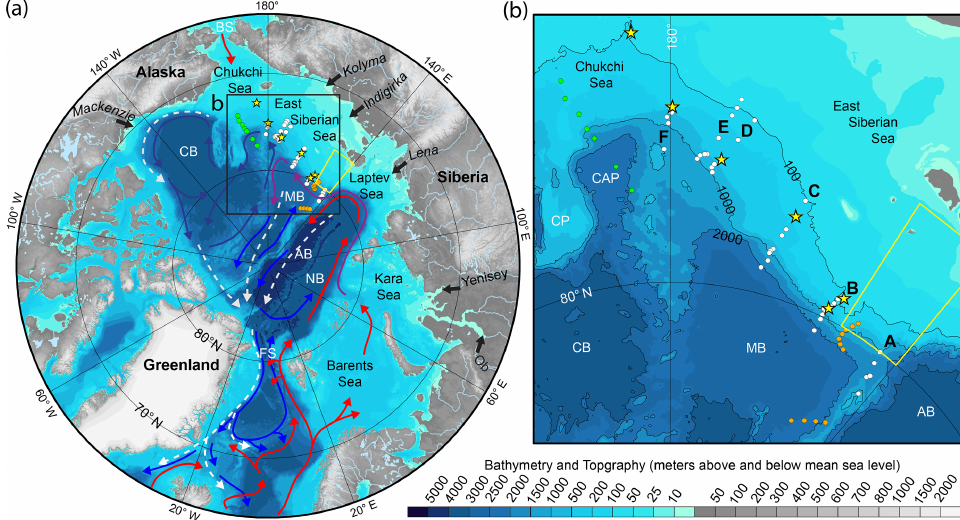
Figure 1. Map of the Arctic Ocean with general currents at intermediate depths over the deep basins and exchange with the surrounding oceans (a) . The black frame indicates the investigated area that is illustrated in panel (b) with the hydrographic station positions of sections A to F as white points and those of sediment cores in yellow stars. The Arctic Ocean Section 1994 stations are in green and the orange points show the positions of the ACSYS 96 stations, which are used as historic references. The yellow frame borders the area where the historic sea-ice coverage has been evaluated; see Fig. 10. Abbreviations: Fram Strait (FS), Bering Strait (BS) Nansen Basin (NB), Amundsen Basin (AB), Makarov Basin (MB), Canada Basin (CB), Chukchi Plateau (CP), and Chukchi Abyssal Plain (CAP).